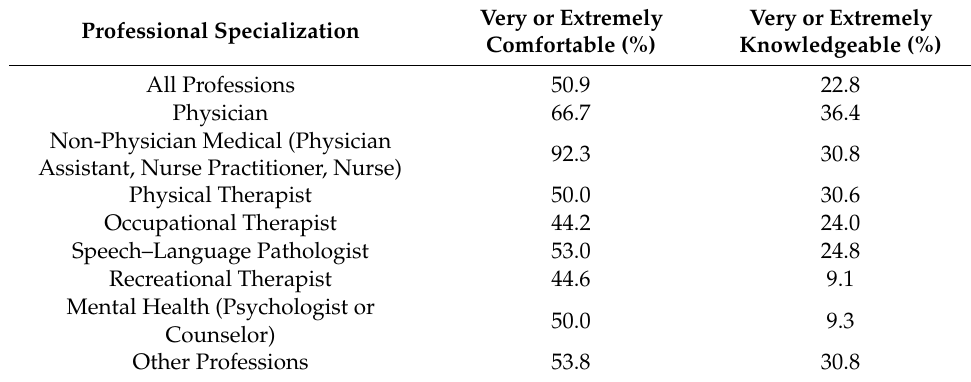
Table 6. Level of comfort integrating mobile rehabilitation (mRehab) technologies into practice and level of knowledge of current rehabilitation technologies, by profession.